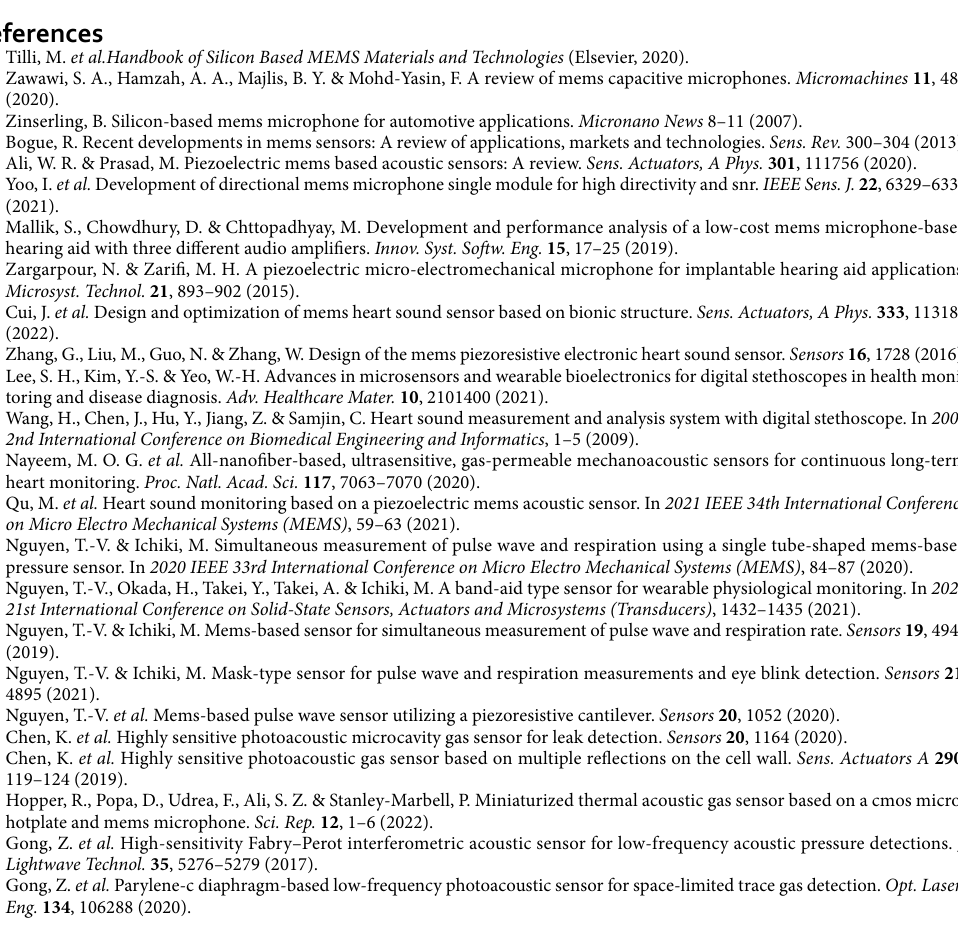
Fig. 1C. The initial resistance of the cantilever was approximately 5.4 k (cid:31) . Heart sound measurement. The jig attached to the chest of a subject was fabricated using an inkjet 3D printer (AGILISTA, Keyence, Japan) with a minimum pattern width of 15 µ m. The authors declare that the jig does not have skin-irritating properties. The experimental protocols in this paper were approved by the IRB of Ethics in Ergonomic Experiments (2019-988-B) in the National Institute of Advanced Industrial Science and Technology (AIST), including any relevant details. Moreover, the authors declare that all experiments were car- ried out following the relevant guidance and regulations and confirm that informed consent was obtained from all